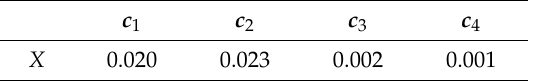
Table 3. Conditional probability for feature attribute vector X under the condition of tourist site